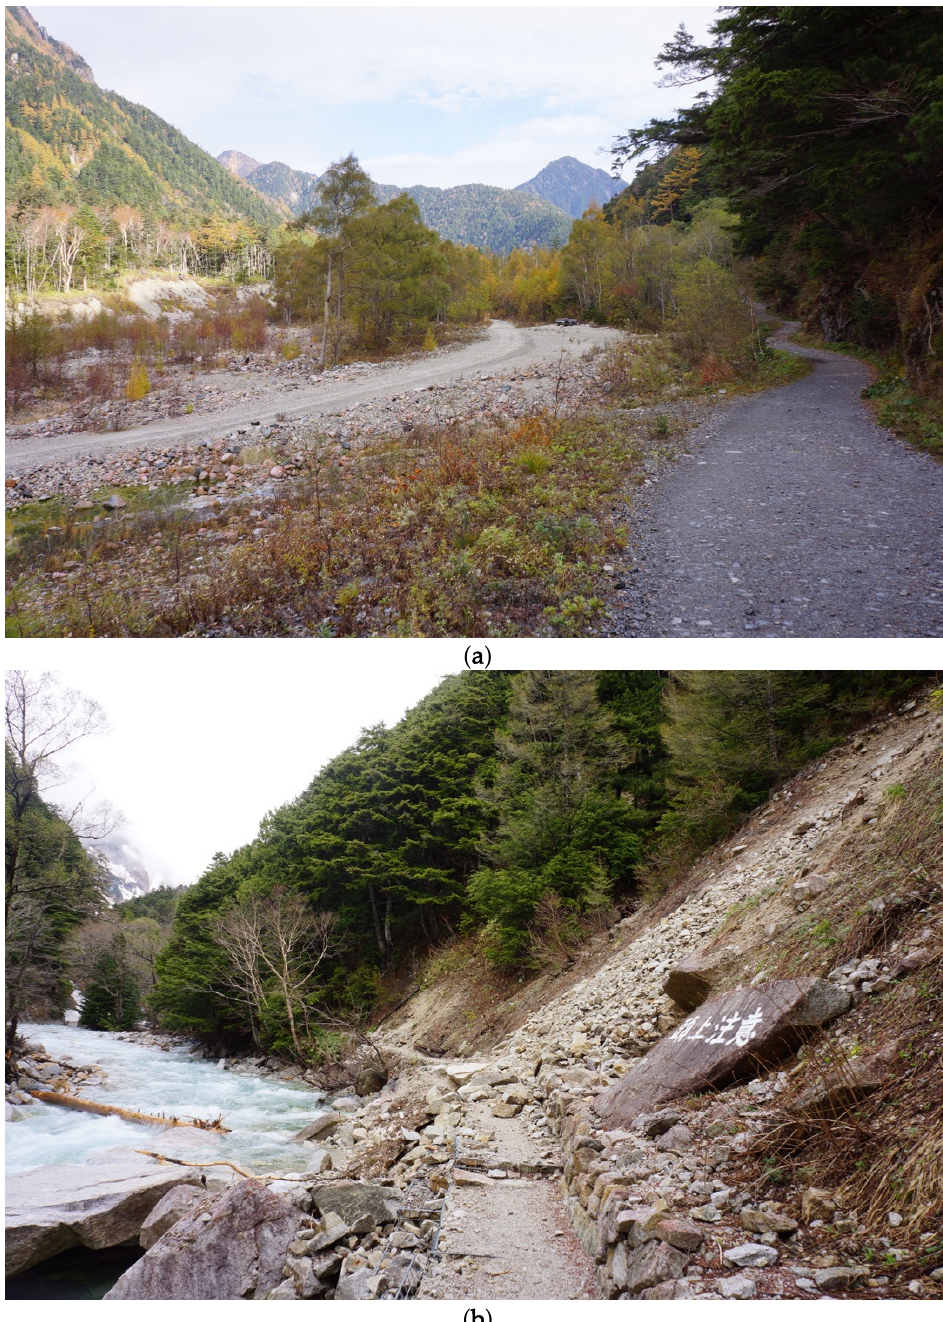
Figure 5. Human modification of the landscape and nature’s forces to reclaim their territory working side by side. ( a ) (above) The main trail near Tokusawa area (on the right) and a supplemnatry trail (center) opened up to avoid spring snowmelt and landslides from above. ( b ) (below) Rockfall on the trail upstream: such dynamic landscape properties are essential for active riverbed formation. Photos provided by the author.